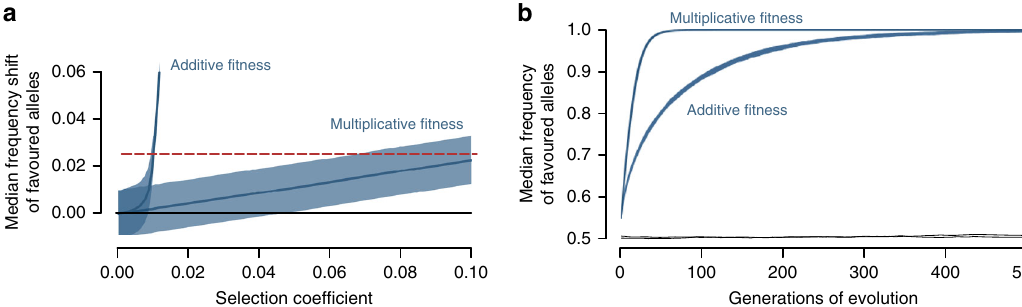
Fig. 5 Allele frequency shifts in simulations of polygenic directional selection. a Response to viability selection on 100 loci over a single generation for a range of per-locus selection coef fi cients and two different fi tness schemes. For each of the 10,000 replicate simulations, the median shift of the selectively favored allele across the loci was recorded. The blue curves represent the median of these values across the replicates, and the blue bands give the associated 95 percentiles. The dashed red line indicates the median frequency shift of the stream alleles observed across the 126 target SNPs in the fi eld experiment. b Response to selection on 100 loci over multiple generations, for the same two fi tness schemes as in a . For each fi tness scheme, a single selection coef fi cient compatible with the experimentally observed median allele frequency shift was chosen (see a ; 0.1 and 0.01 for multiplicative and additive fi tness). The blue bands display the full range across the 40 replicate simulations of the median frequency of the favorable allele across all selected loci. The black lines indicate the grand median allele frequency of the focal allele across 20 neutral loci and replicate simulations (the lines are not labeled because they largely overlap between the two fi tness schemes). In both a and b , the initial frequencies of the favorable alleles at the selected loci were drawn at random from the distribution observed empirically at the target SNPs.